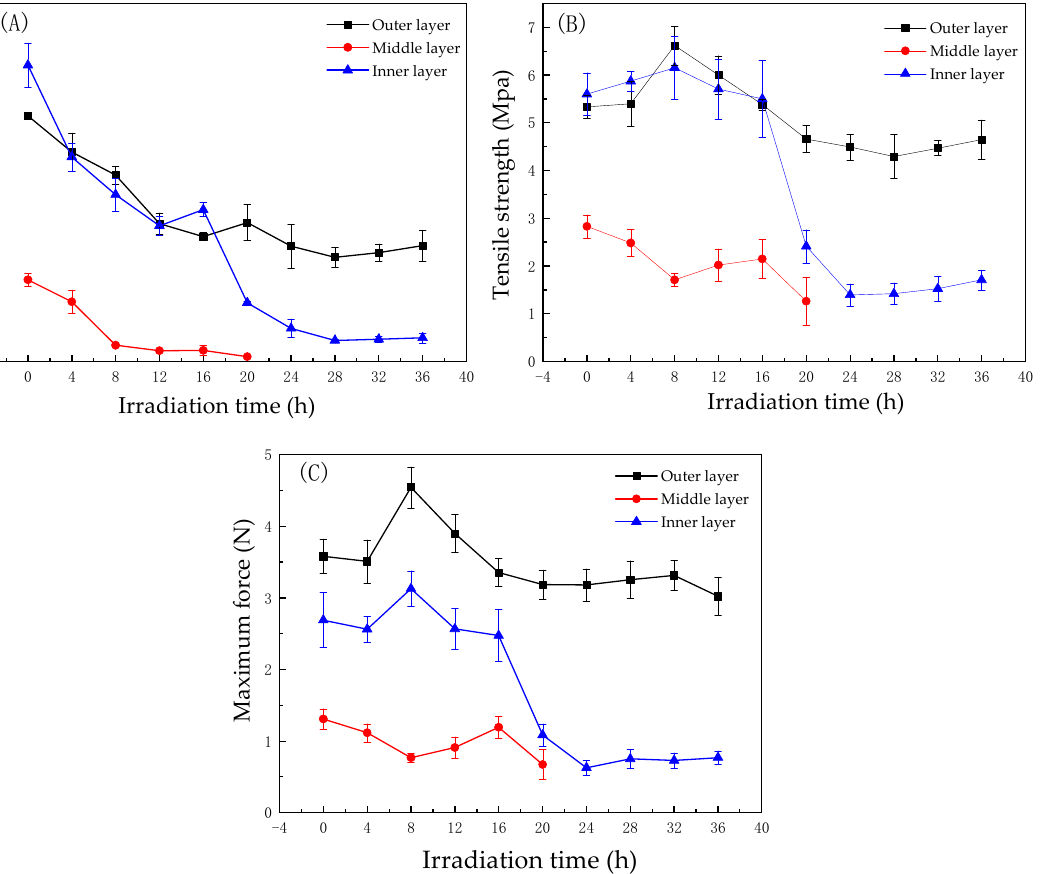
Figure 2. Change in mechanical performance of each layer of the masks under different UV irradiation time. ( A ) Variation of elongation at break; ( B ) tensile strength; ( C ) maximum force. (For each condition, N = 6).